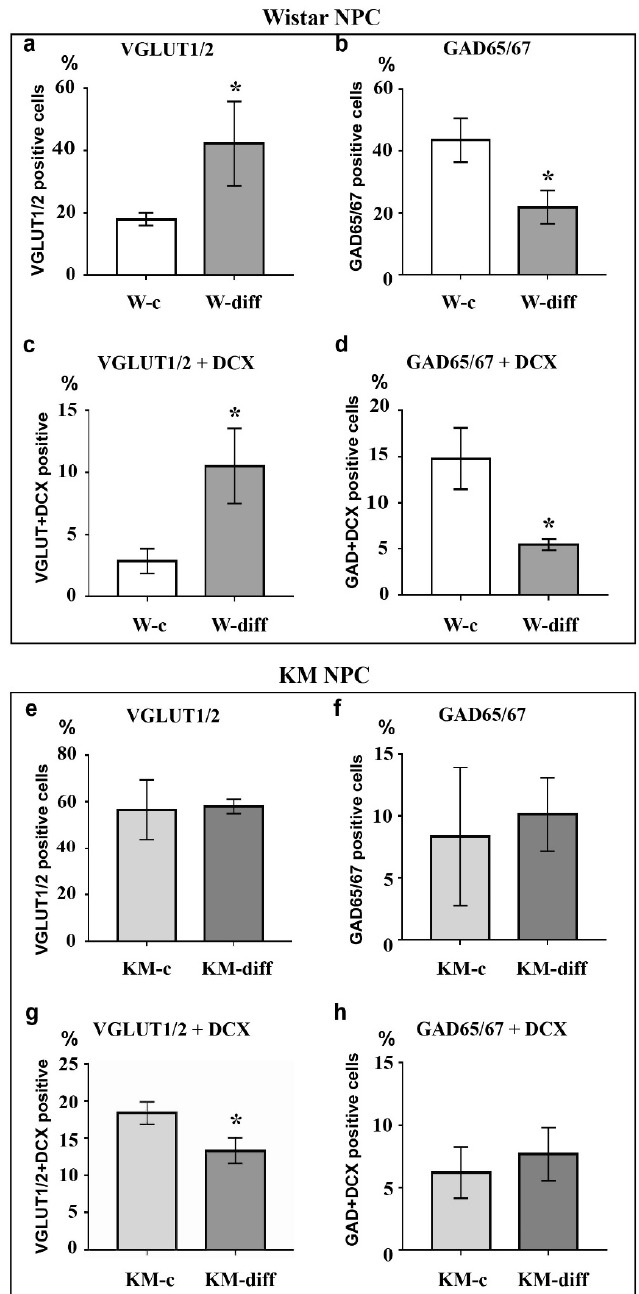
Figure 4. Analysis of VGLUT1 / 2, GAD65 / 67, and doublecortin (DCX) expression in cultured NPC after stimulation of glutamatergic di ff erentiation. Stimulation of Wistar NPC culture (W-di ff ) induced the significant increase in the number of VGLUT1 / 2-positive ( a ) and VGLUT1 / 2 / DCX-double positive ( c ) cells and decrease in the number of GAD65 / 67-positive ( b ) and GAD65 / 67 / DCX-double positive ( d ) cells as compared with control (W-c). The same treatment of KM NPC (KM-di ff ) did not evoke any considerable changes in VGLUT1 / 2 ( e ) and GAD65 / 67 ( f ) expression as well as in co-expression of GAD65 / 67 ( h ) with DCX in comparison to control (KM-c). However, the number of VGLUT1 / 2 / DCX double positive cells in KM NPC culture was decreased after stimulation ( g ). Axis x: experimental groups. Axis y: number of immunopositive or double immunopositive cells as % of the whole cell number calculated with use of DAPI-stained cell nuclei. The data are calculated from three independent experiments. Results are shown as mean ± SD. Significant di ff erences from control: * p <